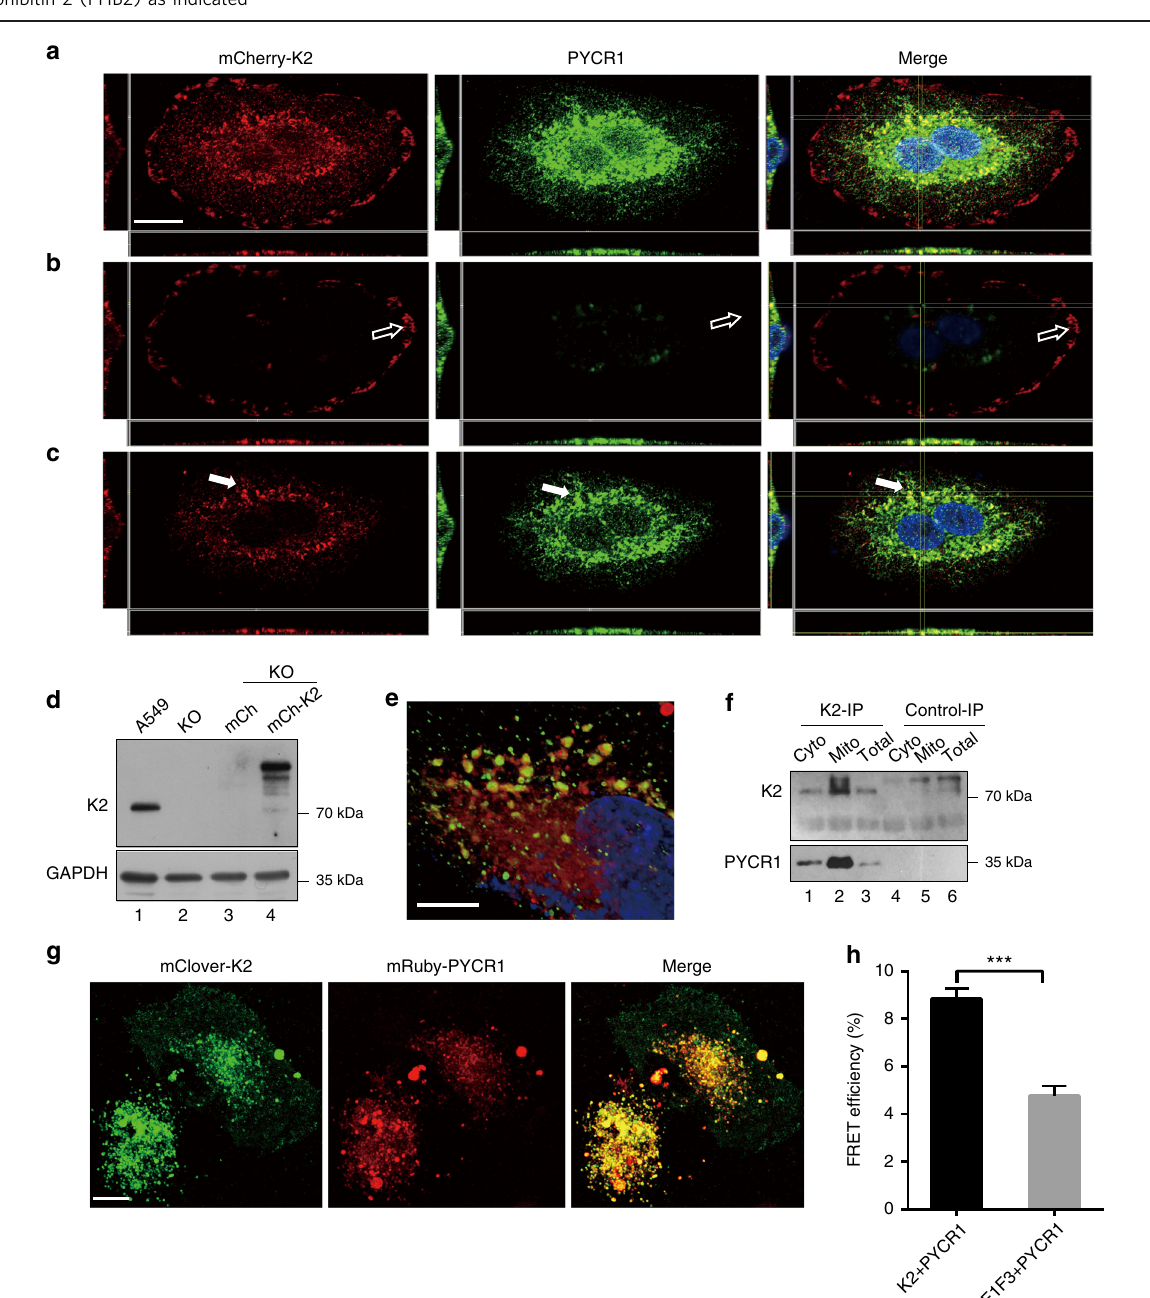
Fig. 1 Kindlin-2 interacts with PYCR1 and colocalizes with PYCR1 in mitochondria. a , b Co-IP of PYCR1 with kindlin-2. Human A549 ( a ) or HCI-H358 ( b ) cells were analyzed by IP with monoclonal anti-kindlin-2 antibody or irrelevant mouse IgG (as a control) as described in the Methods. The cell lysates (lane 1), control IgG (lane 2), and anti-kindlin-2 immunoprecipitates (lane 3) were analyzed by western blotting with antibodies as indicated. c Co-IP of PYCR1 with FLAG-kindlin-2. Kindlin-2 KO A549 cells were infected with lentiviral vector encoding 3xFLAG-tagged kindlin-2 (3 fl -K2) or control lentiviral vector lacking kindlin-2 sequence (3 fl ). The 3 fl -K2 and control 3 fl infectants were analyzed by IP with anti-FLAG antibody. The 3 fl -K2 cell lysates (lane 1) and IP samples from 3 fl (lane 2) or 3 fl -K2 (lane 3) cells were analyzed by western blotting with kindlin-2 or PYCR1 antibodies. d GST-kindlin-2 bound to glutathione-Sepharose beads were incubated with increased concentrations (lane 2, 0 μ g ml − 1 ; lane 3, 10 μ g ml − 1 ; lane 4, 20 μ g ml − 1 ; lane 5, 40 μ g ml − 1 ) of puri fi ed His-tagged PYCR1. GST-kindlin-2 fusion protein pulldown was analyzed as described in the Methods. The sample in lane 1 was prepared as that in lane 4, except GST-kindlin-2 was replaced with GST. e – g GST-tagged full-length or mutant forms of kindlin-2 (illustrated in e ) or GST alone (as a negative control) were used to pull down His-tagged PYCR1 as described in the Methods. The inputs, GST and GST-kindlin-2 fusion protein pulldowns, were analyzed by western blotting with antibodies against His and GST, respectively. h A549 cells were plated on fi bronectin-coated coverslips and dually stained with mouse monoclonal anti-kindlin-2 and rabbit polyclonal anti-PYCR1 antibodies. The primary antibodies were detected with Alexa Fluor 488- conjugated anti-mouse IgG or Alexa Fluor 647-conjugated anti-rabbit IgG secondary antibodies. Scale bar = 10 μ m. i The cytosolic fraction (Cyto, lane 1), mitochondrial fraction (Mito, lane 2), and total cell lysates (Total, lane 3) were analyzed by western blotting with antibodies to kindlin-2, PYCR1, tubulin, and prohibitin-2 (PHB2) as